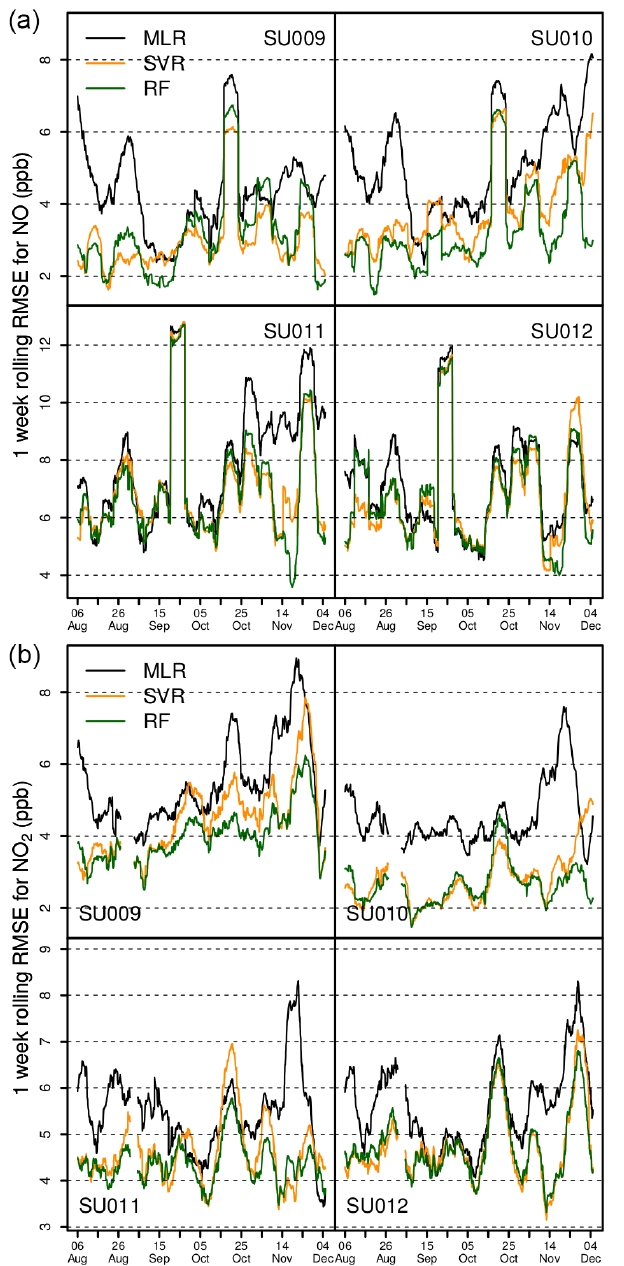
Figure 8. Time series of mean daily residuals for NO and NO 2 es- timates, from 1h average data. Smooth lines from locally weighted polynomial regression, by loess function in R, were